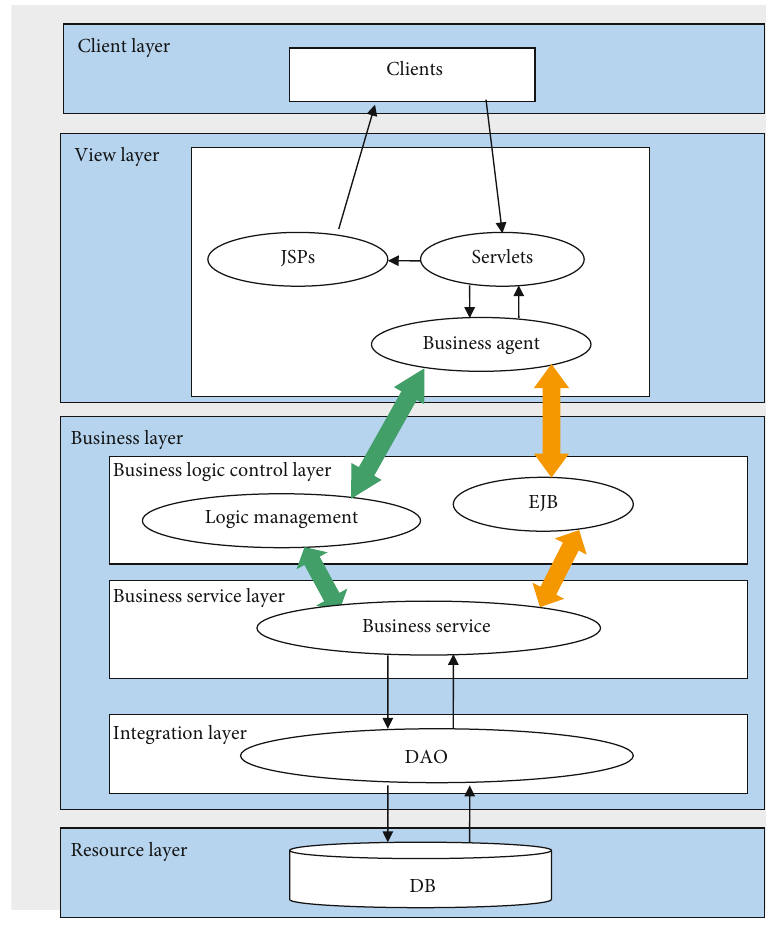
Figure 7: DBMS of